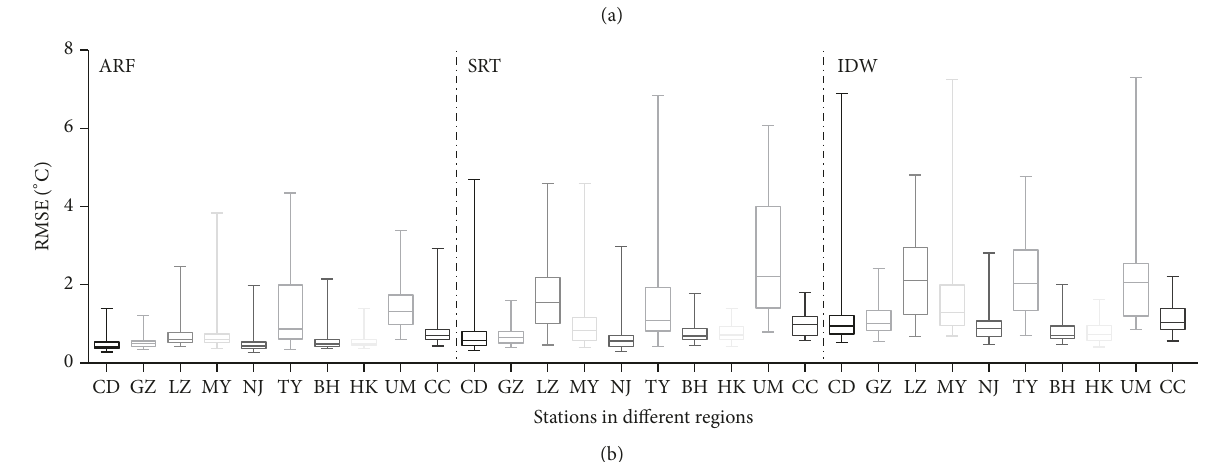
Figure 10: Performance comparisons for the ARF, IDW, and SRT methods for stations in different regions: (a) the contrast condition of MAE; (b) the contrast condition of RMSE.